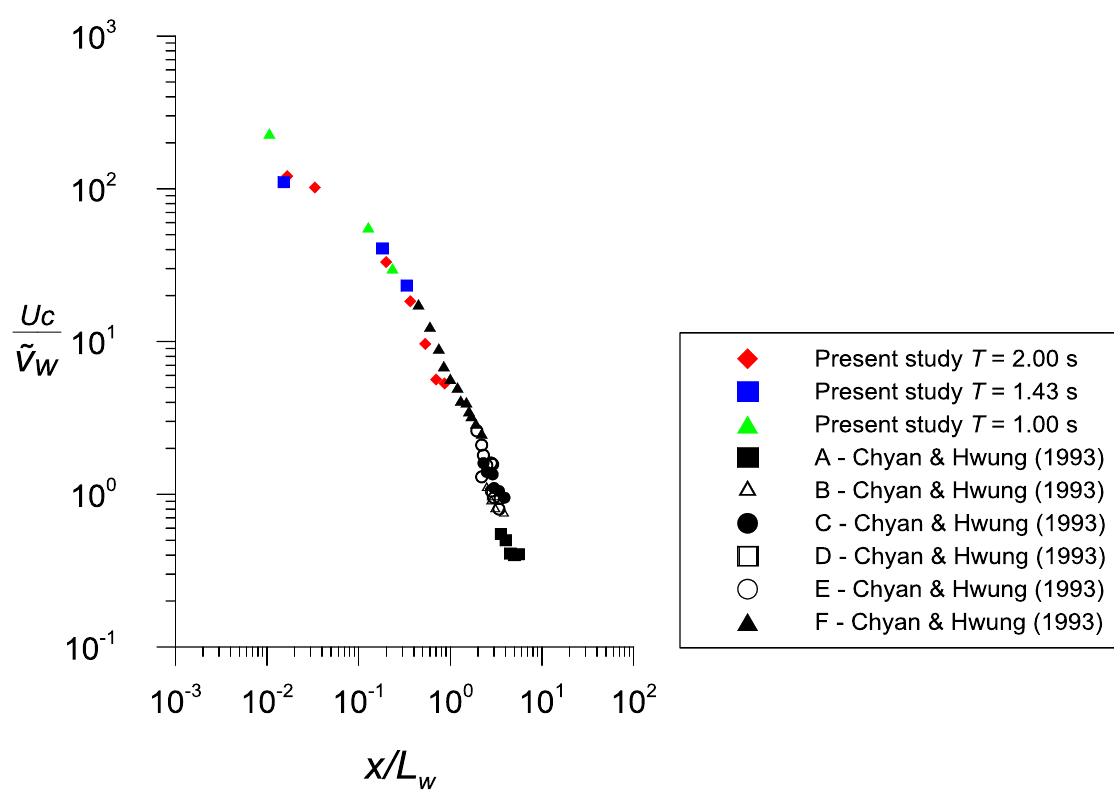
Figure 11. Distribution of the dimensionless values of U c along the dimensionless distance.